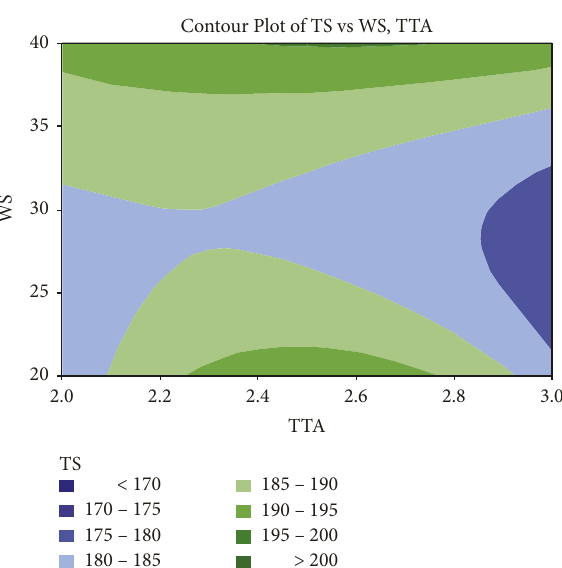
Figure 16: Contour plot TS vs WS and